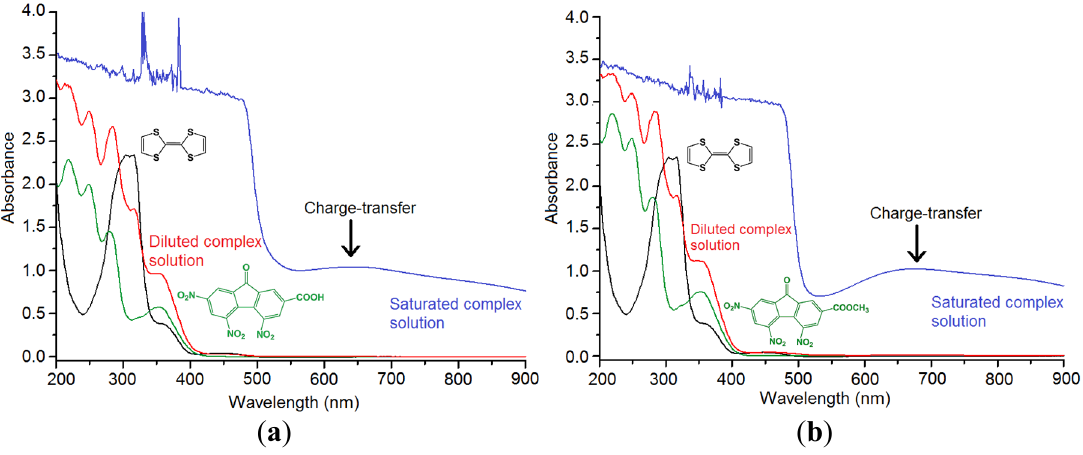
Figure 3. Electronic spectra for TTF, C2TNF, MeC2TNF, complex TTF-C2TNF, 1 ( a ), and complex TTF-MeC2TNF, 2 ( b ). Compounds are dissolved in CH 3 CN, and in the case of complexes, diluted (red spectra) and saturated (blue spectra) solutions are used. Black and green spectra are for neutral donor and acceptor components,